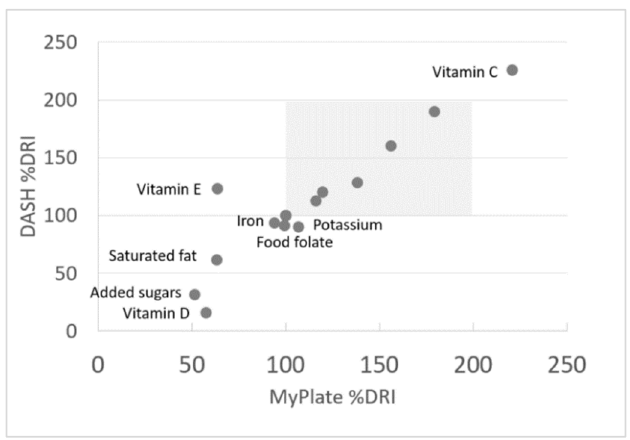
Figure 2. Dietary Reference Intakes (DRIs) for nutrients values from MyPlate and DASH menu plans for non-pregnant women aged 31 – 50 years. This shows the relationship between the nutrient composition of the DASH menu plan and the MyPlate menu plan, expressed as percent of the dietary reference intake for each nutrient. Each data point represents the mean of 7 days of each menu plan (the menu plans are provided in Appendix B). DASH: Dietary Approaches to Stop Hypertension.